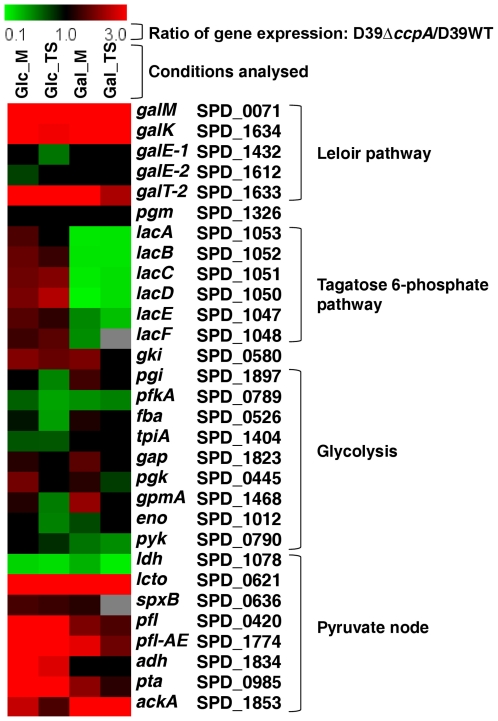
Visual representation of the effect of CcpA on the transcription of genes involved in key basic metabolic processes.Ratio's of genes in glycolysis, the Leloir and tagatose 6-phosphate pathways, and the pyruvate node, in all four conditions analysed in this study (Glc_M, Gal_M, Glc_TS, Gal_TS) are depicted. On top of the figure, a colour scale is given for the ratio of the expression in the ccpA mutant over that in the wild-type strain. Thus, red means repression by CcpA (upregulation in the microarray analysis) and green means activation by CcpA (downregulation in the microarray analysis). For each gene the D39 locus tag and the gene name is given on the right. No cut-off value was applied for the expression ratios of the genes given in the figure. Genes were considered significantly changed when having a Bayesian p-value and FDR meeting the criteria as outlined in the Materials & Methods. Genes that did not meet these criteria were given a ratio of 1.0 (black colour), meaning no significant change in expression. See Fig. 5 for an overview of these pathways in S. pneumoniae D39.